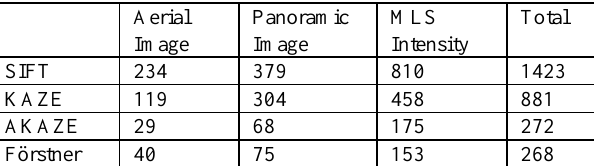
Figure 7 AKAZE keypoints detected in aerial image (left), panoramic image (centre) and MLS intensity image